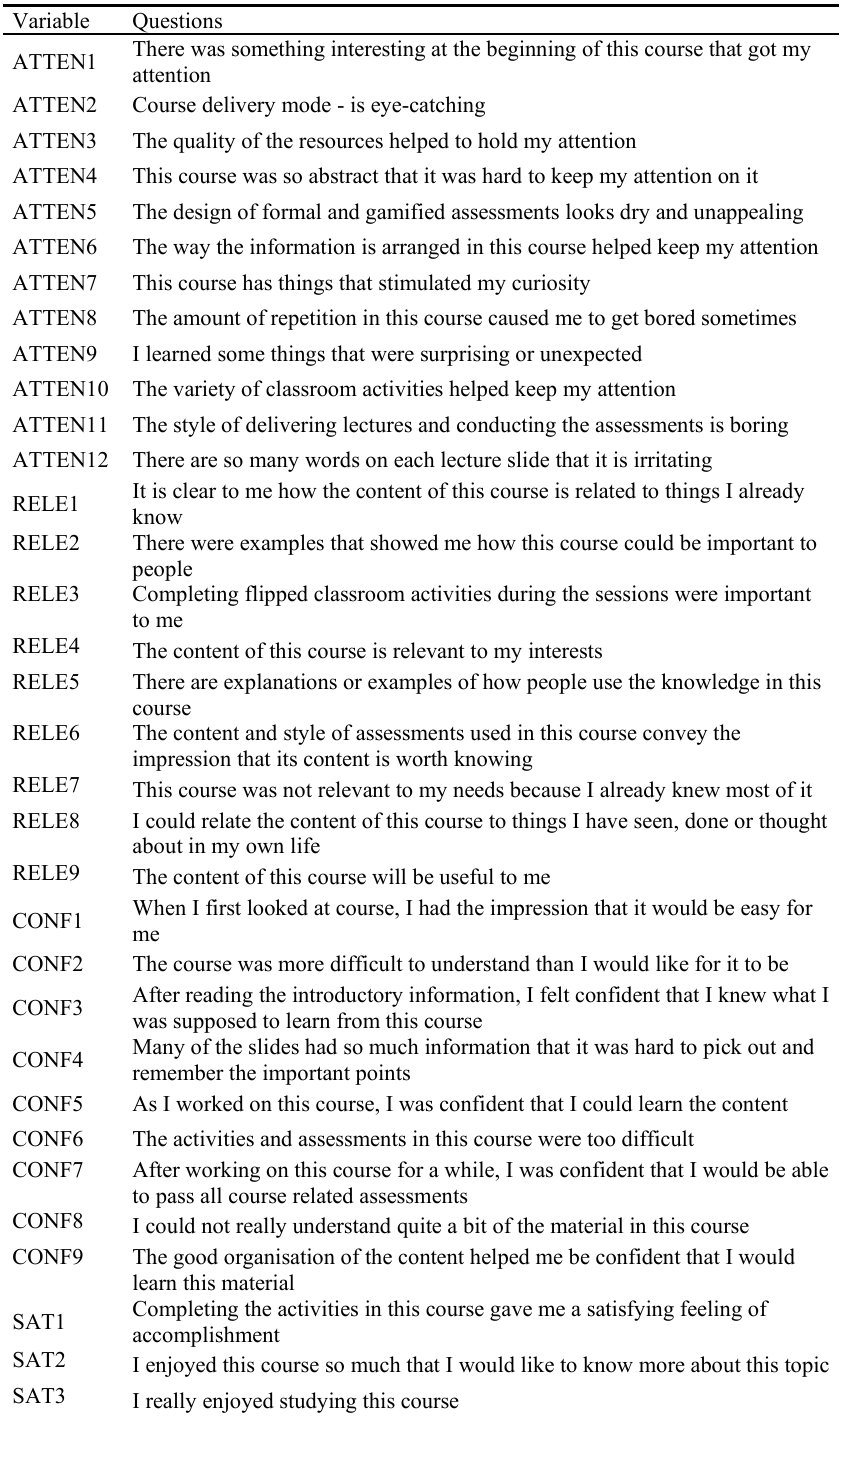
Table. IMMS Survey 36 Questions on ARCS motivational